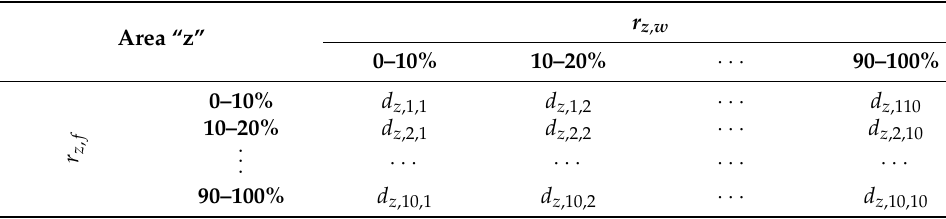
Table 2. Correlation matrix between RES producibilities and load value.